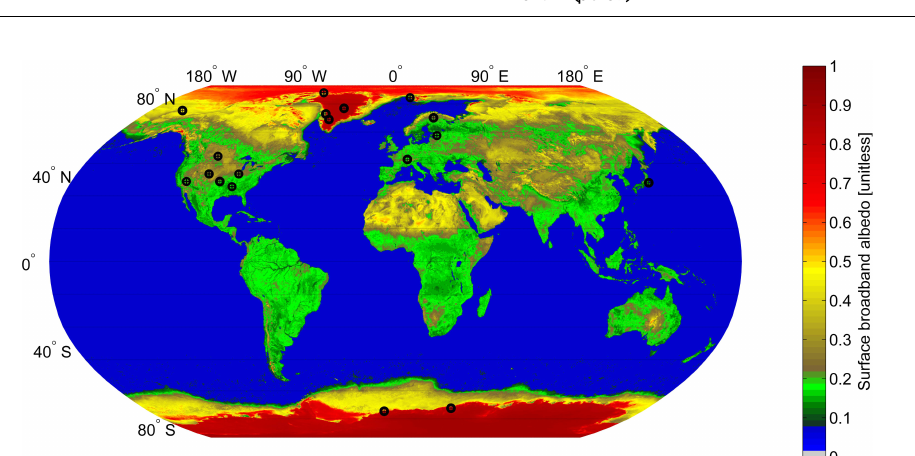
Fig. 2. An averaged composite of the global lat-long grid CLARA-A1-SAL monthly mean products from 2007. The grid cell resolution is 0.25 degrees. Validation sites are overlaid using black cross-in-circle